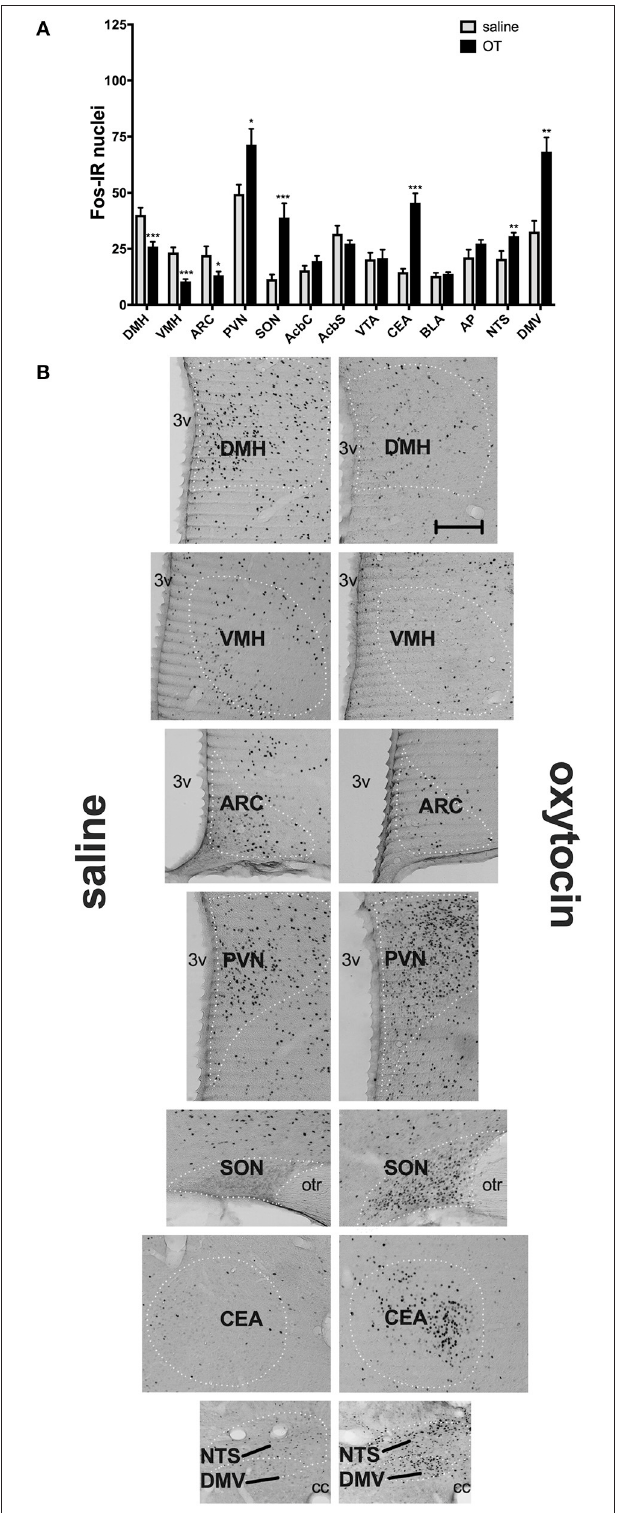
FIGURE 3 | c-Fos immunoreactivity in feeding-related brain sites following i.p. administration of saline or OT (1 mg/kg) in animals that had no access to